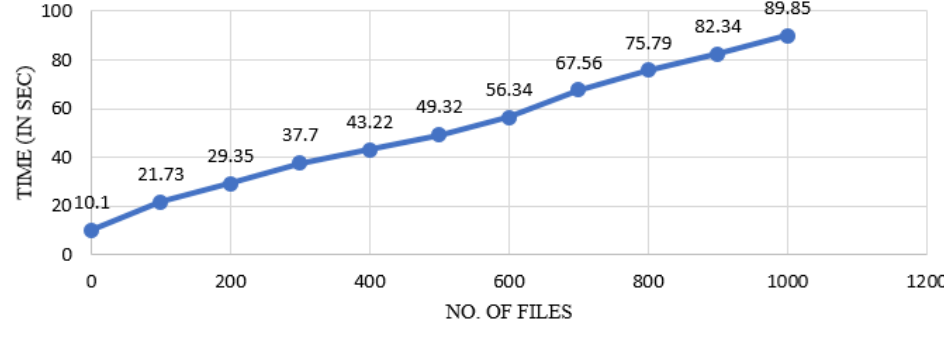
Figure 10. Index Formation Time Graph.